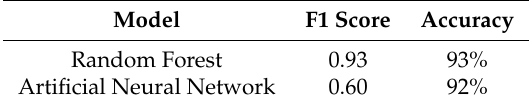
Table 3. Accuracy and F1 score for all the models (imbalanced